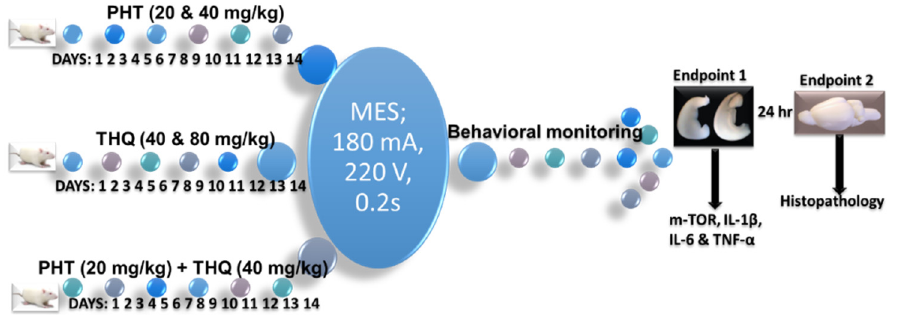
Figure 11. Scheme of the treatment.